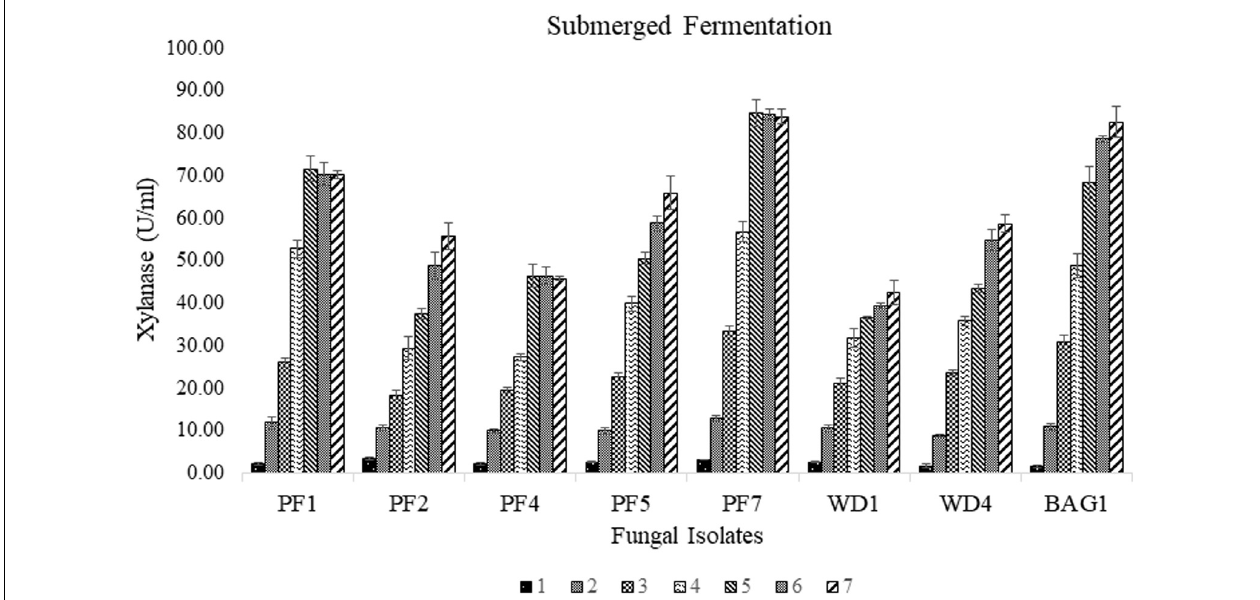
FIGURE 1 | Secondary screening of fungal isolates by submerged fermentation using corncob as sole carbon source for xylanase production (U/ml) with respect to incubation time (days).